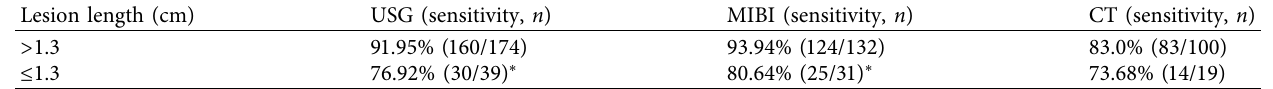
Table 4: Sensitivity of imaging methods in two groups classified by lesion length. Lesion length (cm)